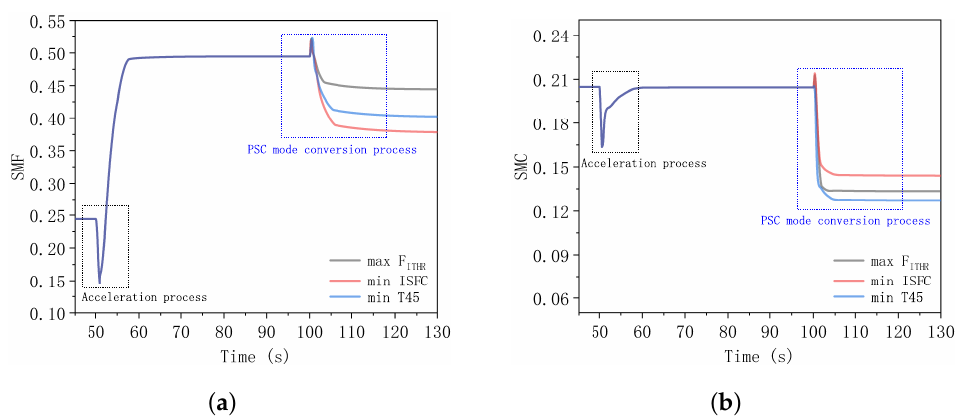
Figure 17. ( a ) Dynamic analysis of SMF under three modes. ( b ) Dynamic analysis of SMC under three